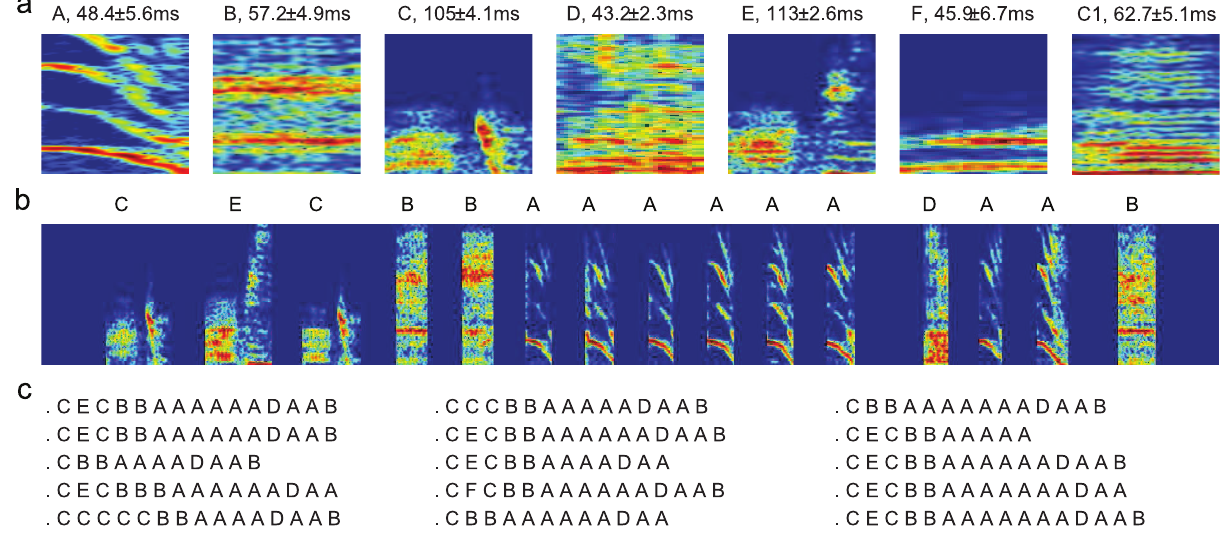
Figure 7. The POMMA (Bird 1). a . The POMM derived from the observed syllable sequences with syllable repetitions taken out. The numbers in the ovals are the state labels. b . The POMMA derived from the model shown in a with the repetitions fitted with adaptation models. c . Examples of syllable sequences generated from the POMMA shown in b . The conventions are the same as in Figure 2. Figure 6. The d -values for the Markov model with adaptation are also larger than those for the POMMA, as shown with the green curves in Figure 6. In particular, the d -values for the N-gram distributions are far beyond the benchmarks and the d -values of the POMMA. Thus, the POMMA is a much better model than the Markov model or the Markov model with adaptation.